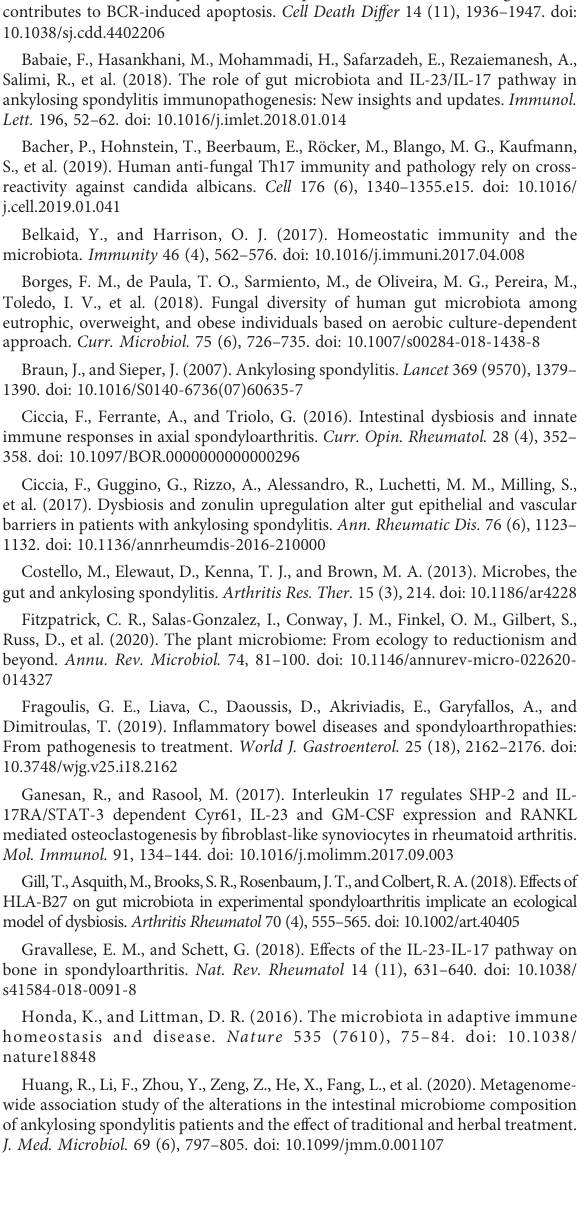
SUPPLEMENTARY FIGURE S7 The RNA sequencing of RAW264.7 co-cultured with K. pintolopesii showed that about 2622 mRNAs changes in expression, with 1016 mRNAs up-regulated and 1606 down-regulated (fold change [FC] ≥ 1.5